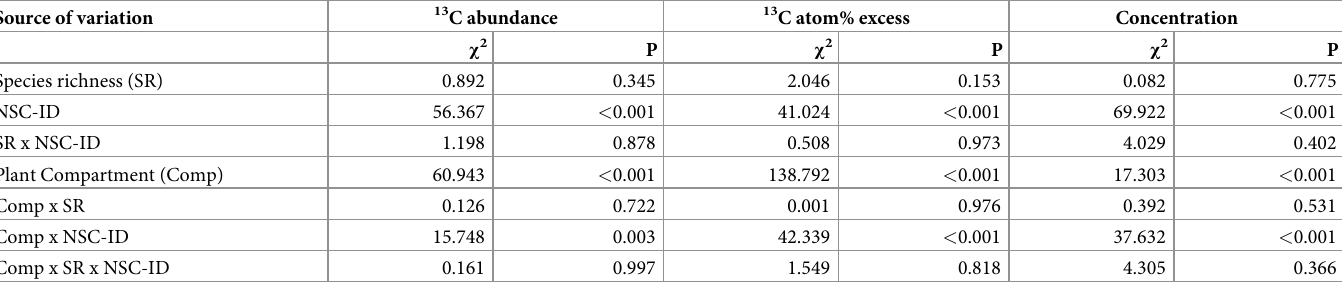
Table 2. Analysis of community-level non-structural carbohydrate concentrations and δ 13 C. Shown is the summary of mixed-effects models testing for differences between plant species richness levels, non-structural carbohydrates (NSC-ID: glucose, fructose, sucrose, RFO, starch) and plant compartment (shoot, root) in 13 C abun- dance, 13 C atom% excess and concentrations.